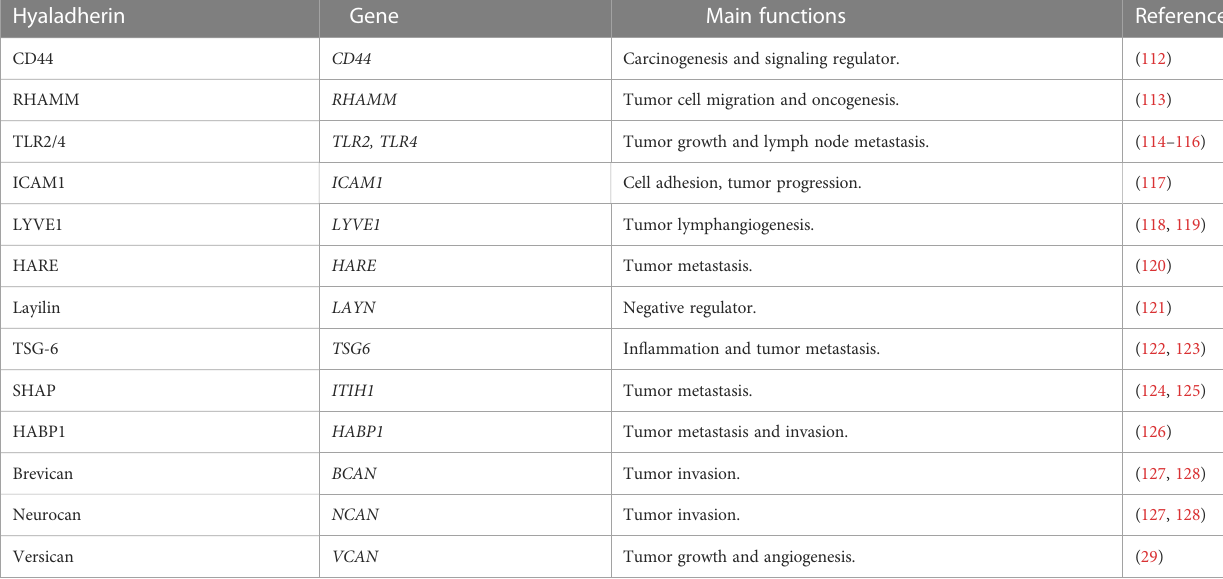
TABLE 2 The roles of major hyaladherins in